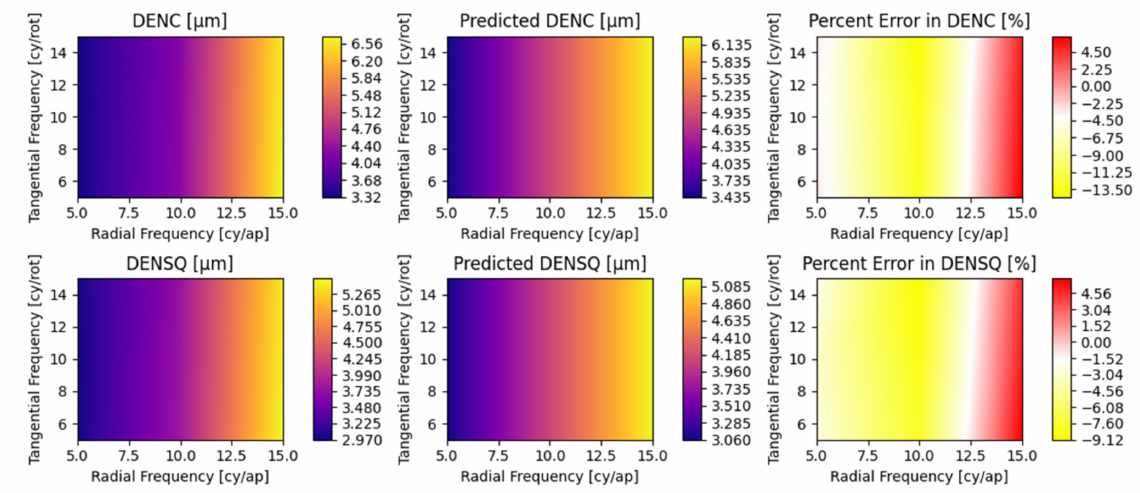
Figure A11. Radial Frequency versus tangential frequency. ( η = ζ = δ = 0, κ = 0.15, σ = 0.05, θ = 30 ◦ ).